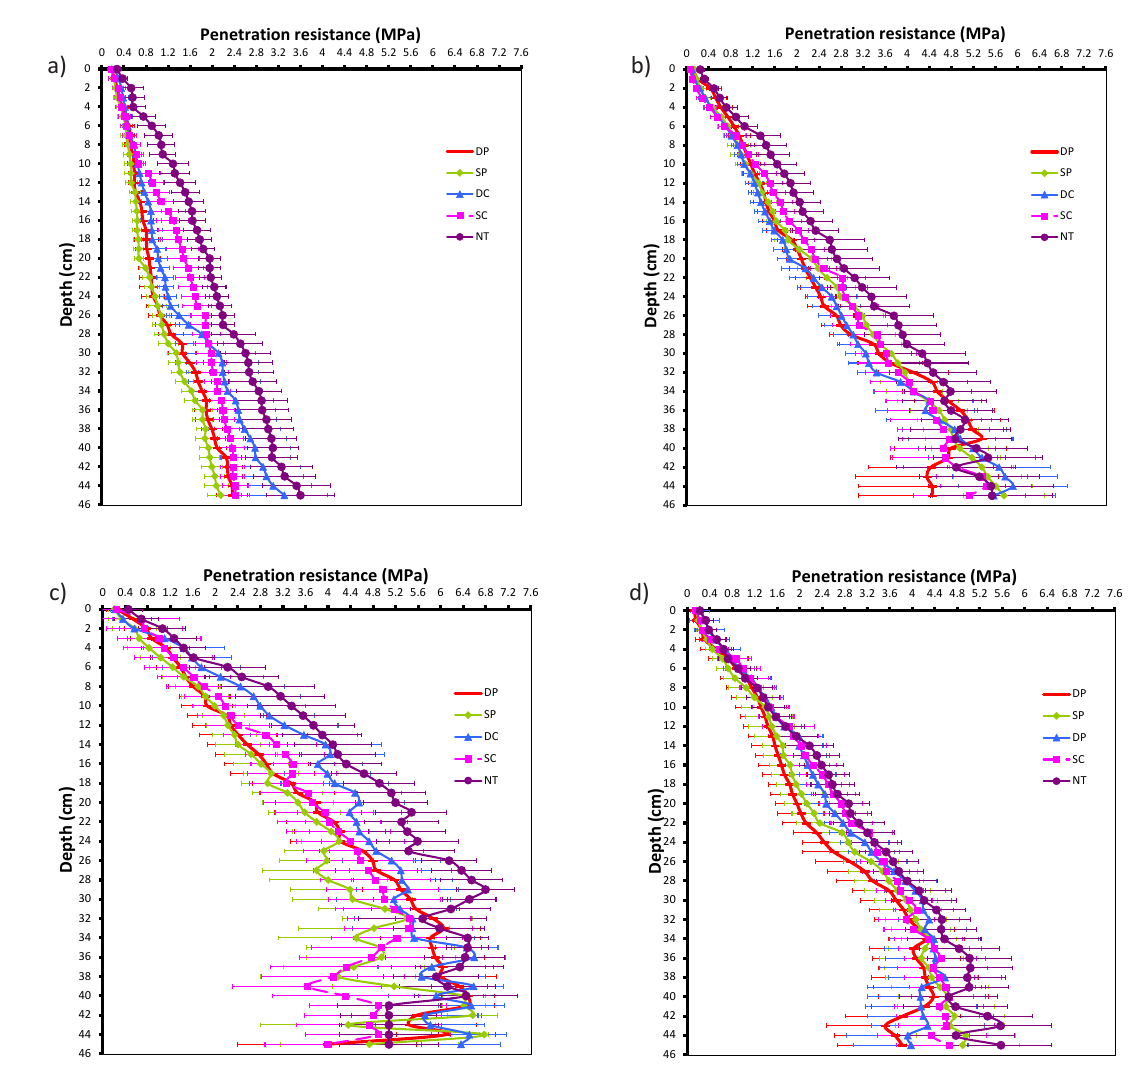
Fig. 2. Soil penetration resistance at different stages of experiment in 2017: a) before pre-sowing tillage in spring; b) after faba bean sowing; c) beginning of faba bean flowering; d) after harvesting. DP = deep ploughing, SP = shallow ploughing, DC = deep cultivation, SC = shallow cultivation, NT = no-tillage (direct drilling). Horizontal bars mean standard